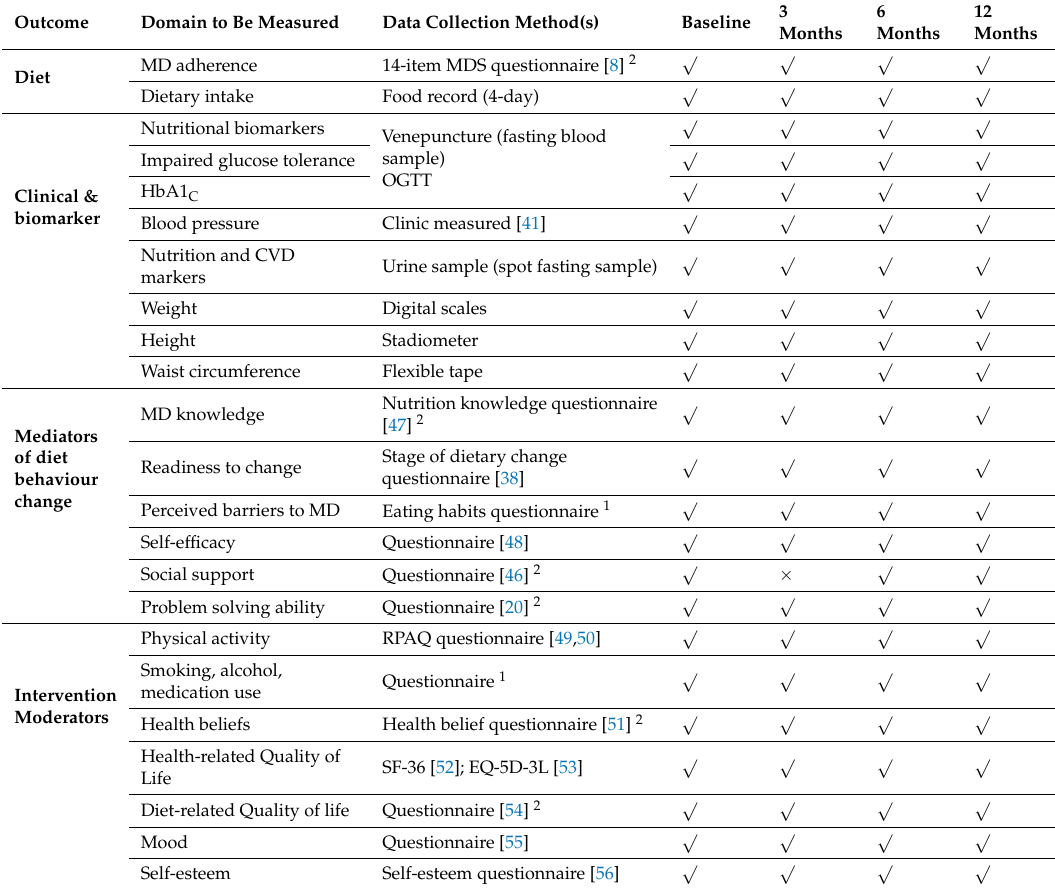
Table 3. TEAM-MED outcome measures and data collection